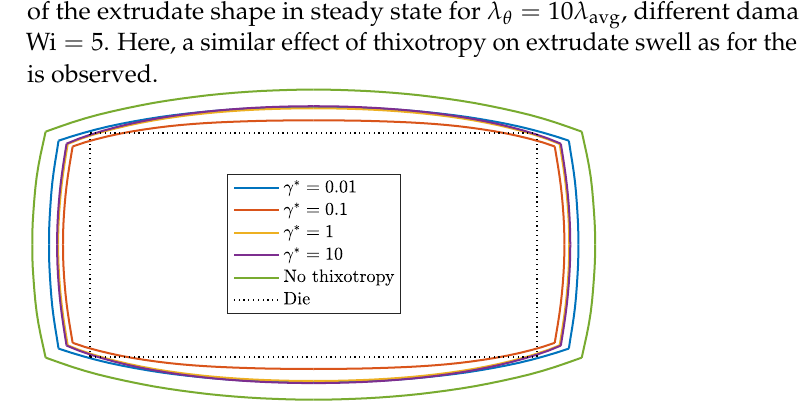
Figure 17. Contour of a 3D extrudate of a thixotropic viscoelastic fluid. Evolution of the structure in the material is modeled using the rate-controlled approach with λ θ = 10 λ avg and different damage parameters for Wi =